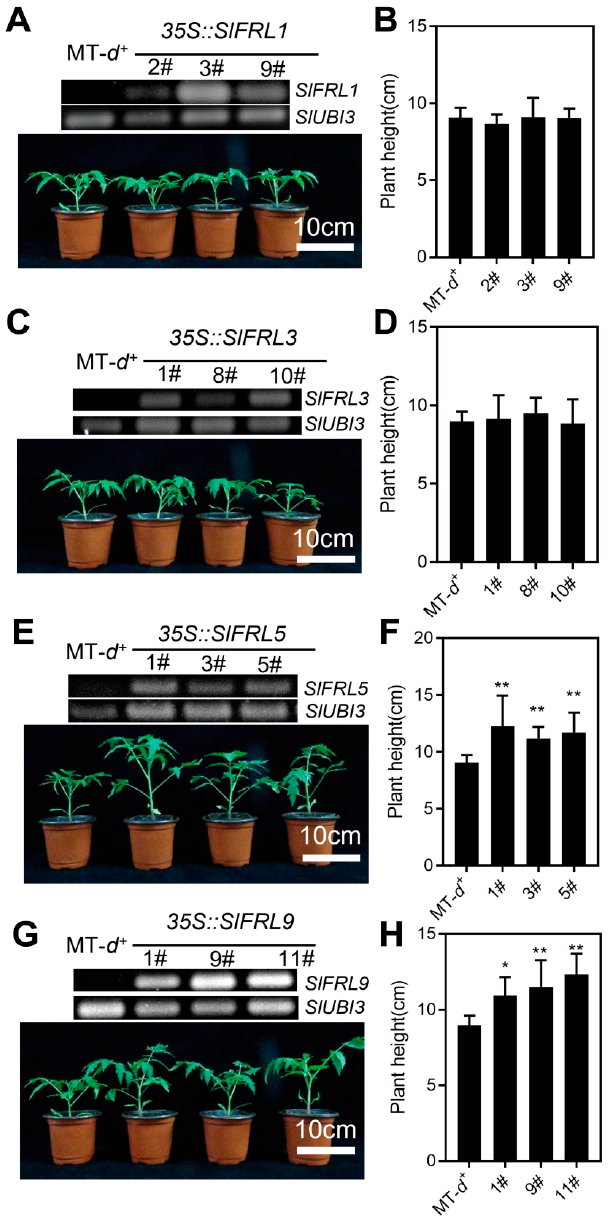
Figure 7. The plant morphology of different overexpression lines in 4 weeks. ( A , C , E , G ) were SlFRL1-OE , SlFRL3-OE , SlFRL5-OE and SlFRL9-OE overexpression lines, respectively. The electrophoresis map was used for identification of the materials by RT-PCR. SlUBI3 was used as the reference gene, and the phenotype of the corresponding transgenic lines for 4 weeks is below. Figs. ( B , D , F , H ) correspond to SlFRL1-OE , SlFRL3-OE , SlFRL5-OE , and SlFRL9-OE plant height at 4 weeks, respectively. n ≥ 8. In the figure one star (*) stand for 5% level of significance while 2 stars (**) for 1%. In Arabidopsis, FRIGIDA and its homologous proteins promote the expression of FLC, which inhibits FT expression, leading to the promotion of late flowering. Late and early flowering was determined based on counting the number of true leaves under the